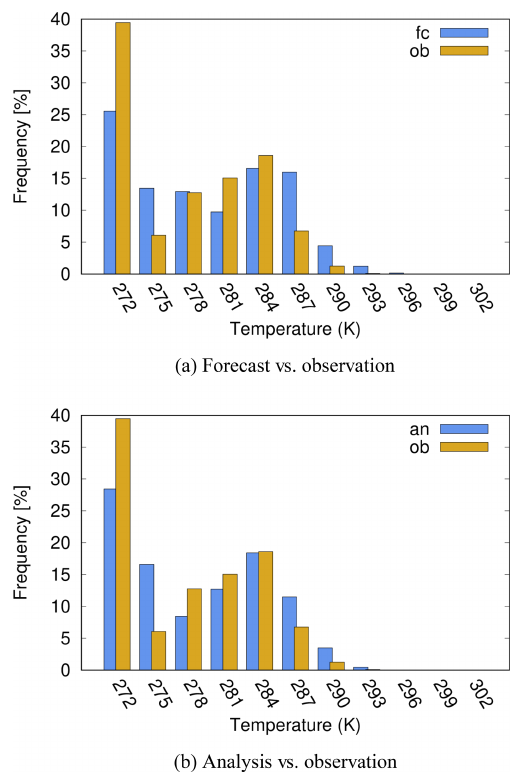
Figure 7. As for Fig. 6 but for Lake